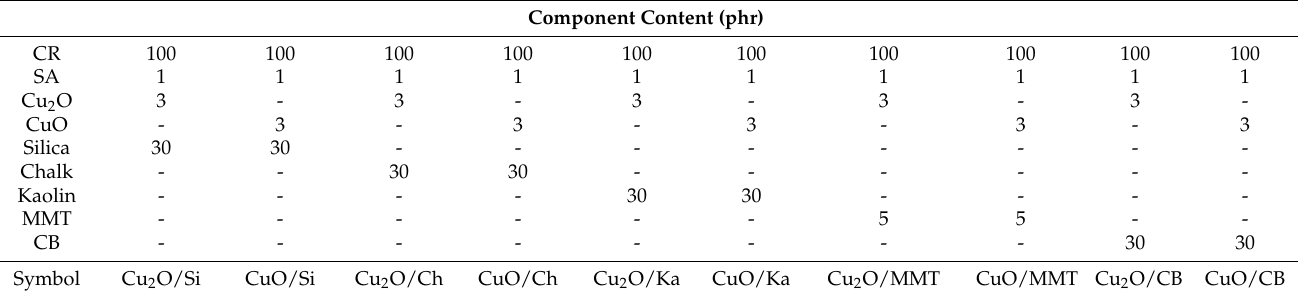
Table 1. Formulation of filled chloroprene rubber (CR) composites and their